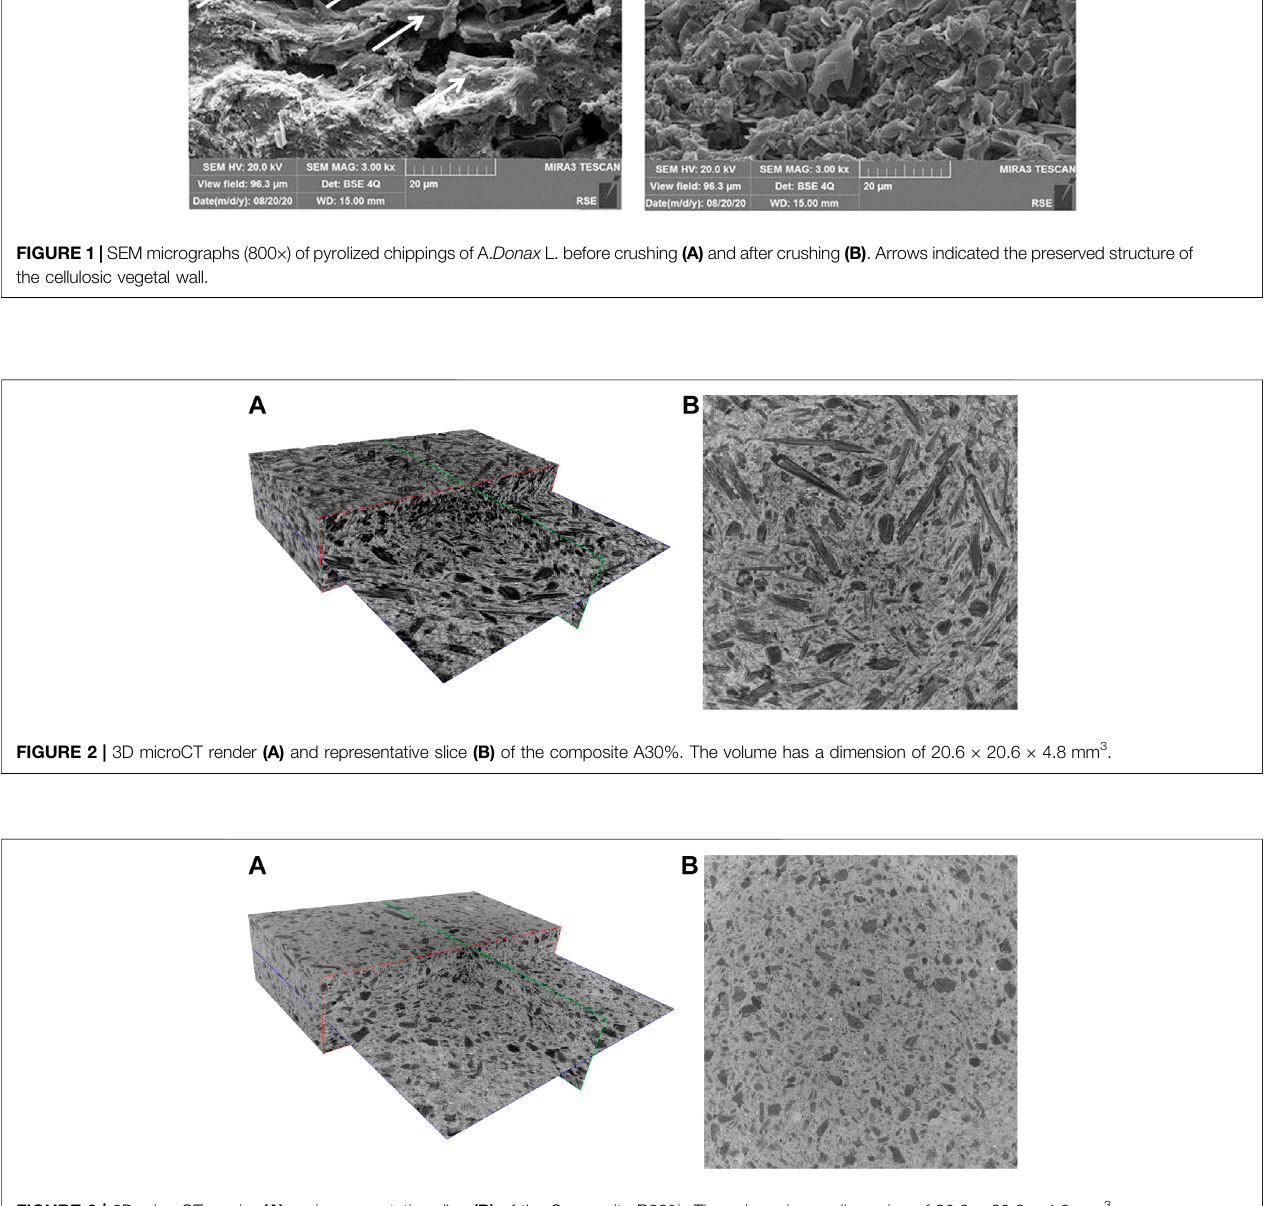
class were counted. The porosity is obtained by ϕ (cid:2) V pores V − 1 . The values of four different composites are summarized in Table 2 and their representative slices are shown in Supplementary Figure S3 .